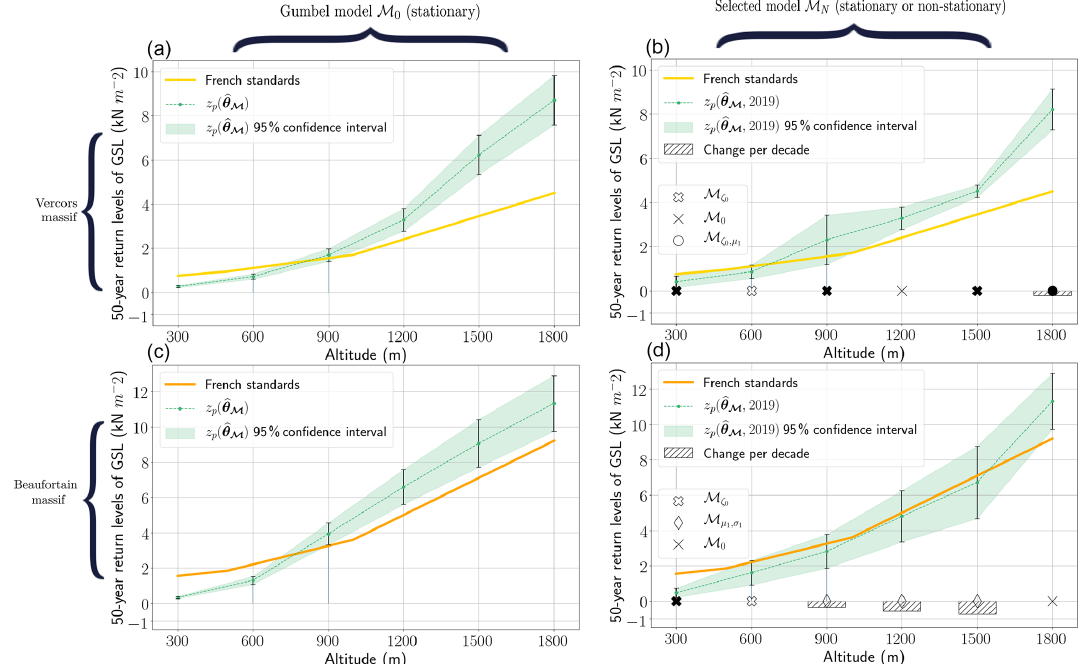
Figure 8. 50-year return levels of ground snow load (GSL) from altitude 300 to 1800m for Vercors (a, b) and Beaufortain (c, d) massifs. Return levels (green line) and their uncertainty (shaded green and black bars) are estimated from the data either with the stationary Gumbel model M 0 (a, c) or with the selected model M N (b, d) . If M N is a non-stationary model, the return level is the effective return level in 2019, and we display the change of return levels per decade (striped histogram), i.e. 10 times the time derivative of return level (Sect.